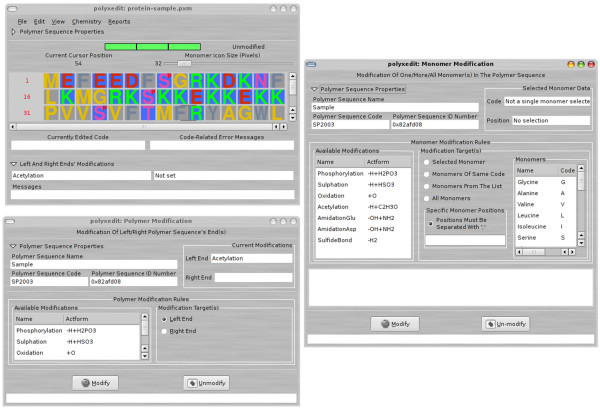
Chemical modifications of the polymer or of monomers. There are two sorts of modifications: 1) the modifications that involve the polymer sequence as a whole (these happen at the left/right ends of the polymer sequence; see left bottom window), 2) the modifications that are set to monomers according to highly flexible criteria, described in the right window, in the "Modification Target(s)" section. The latter modifications are intrinsic to the monomer(s) to which they are set: if the monomer is erased from the sequence, the modification is destroyed also.